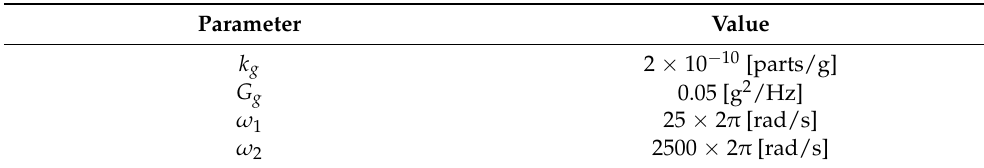
Table 2. Parameter values for the vibration-induced oscillator phase noise calculation [26].